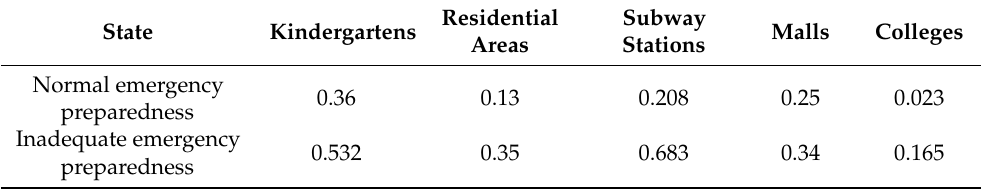
Table 6. Impact of emergency preparedness on changes in casualty probability across scenarios.